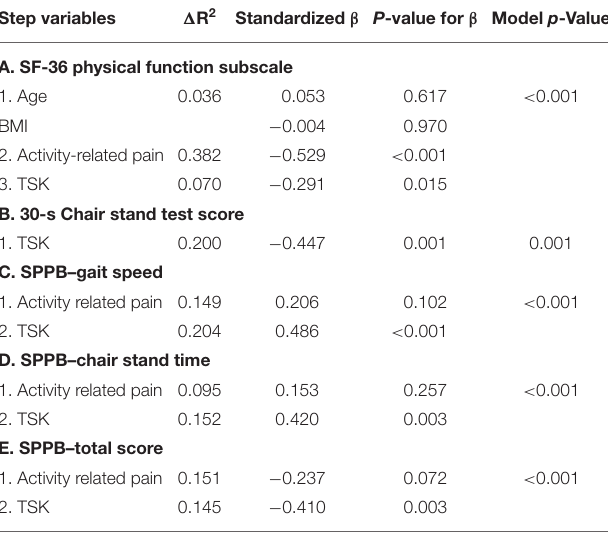
TABLE 4 | Summary of hierarchical regression analyses for self-reported and performance-based physical function variables with TSK as final predictor. Step variables